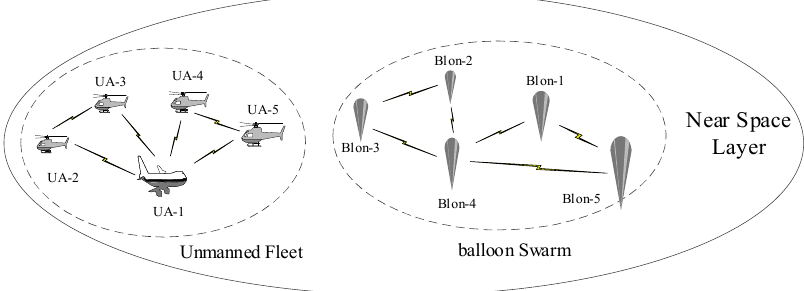
Figure 3. Composition structure of the Near Space layer information system.